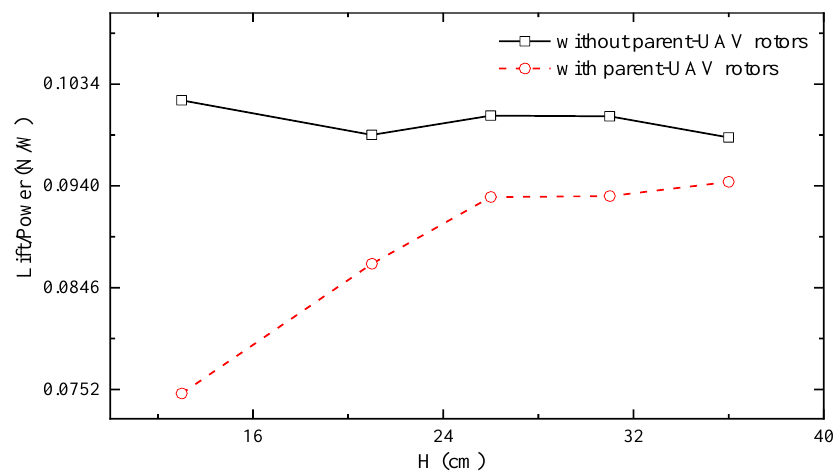
Figure 13. The lift/power of the child UAV in the interference area above a rotor.